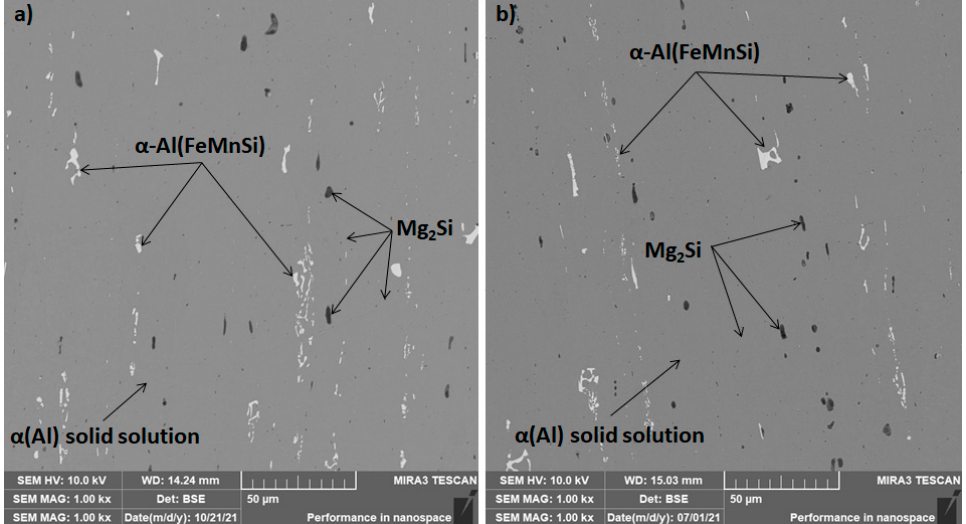
Figure 16. Microstructure of the HAZ after welding three beads and artificial aging at 160 °C for 12 h at a distance of 3 mm from the lower edge and 4 mm from the fusion line ( a ), with preheating at 75 °C and ( b ) 150 °C.